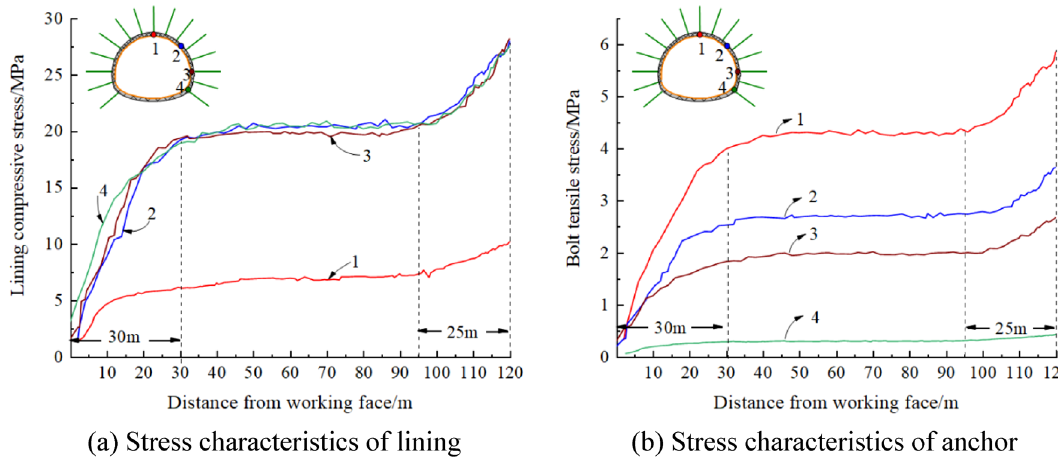
Figure 10. Stress characteristics of the lining and anchor of the Baoshan